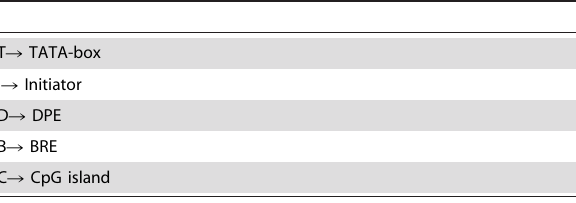
Table 1. Syntactic elements or the nonterminal elements for human promoter region.